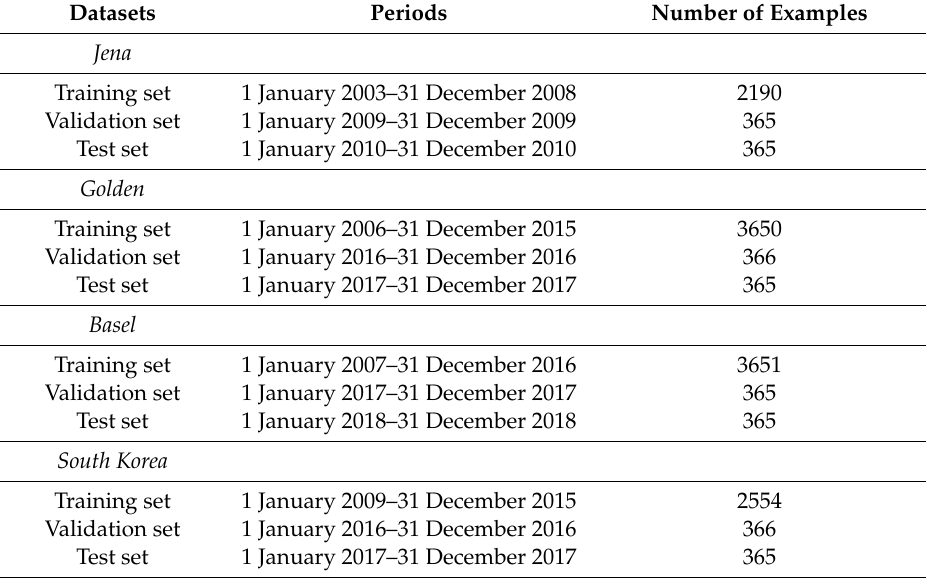
Table 4. Training, validation and test